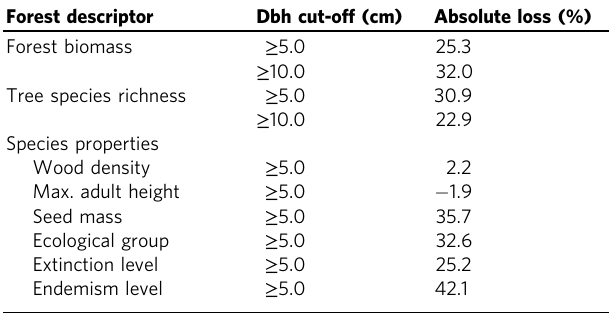
Table 2 The magnitude of the loss of forest biomass, species richness, and species properties due to human-induced impacts.